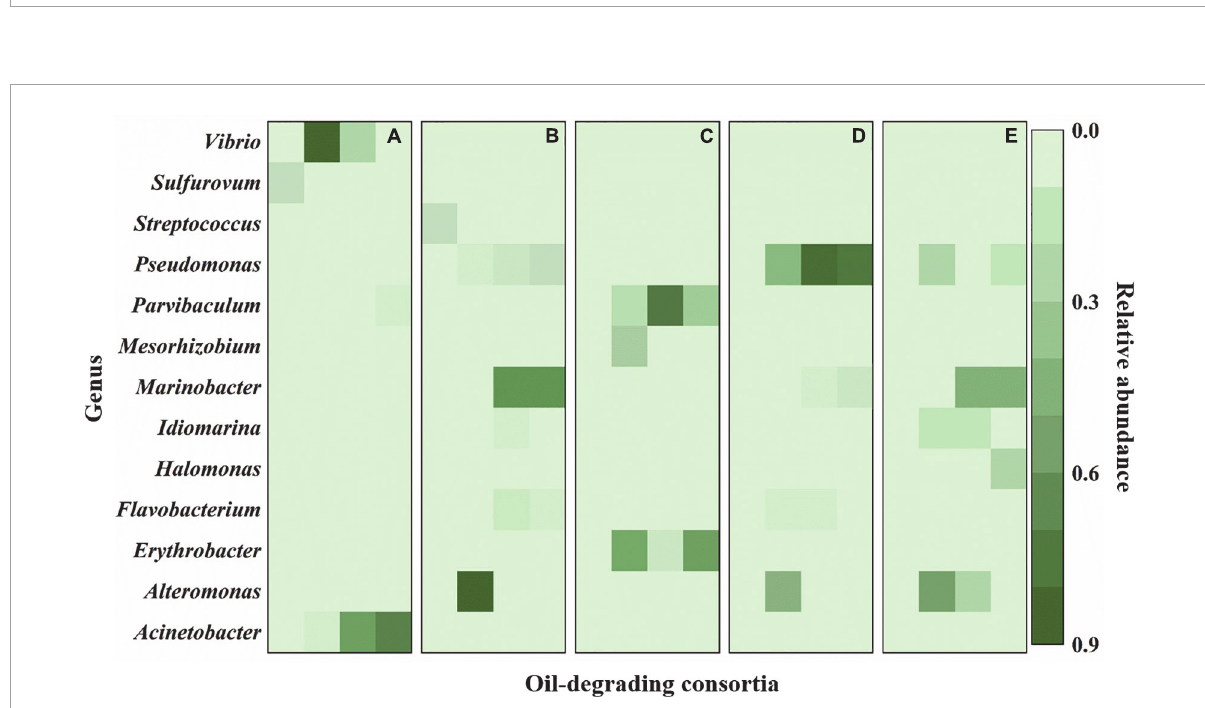
FIGURE3 Variations in bacterial community compositions at genus level during enrichments. (A) The culture F derived from sediment F; (B) the culture J derived from sediment J; (C) the culture I derived from sediment I; (D) the culture N derived from sediment N; (E) the culture G derived from sediment G. In (A–E) , each column from left to right represent cultures before enrichment, after the first enrichment, after the second enrichment, and after the third enrichment, respectively. The green bar represents the relative abundance of